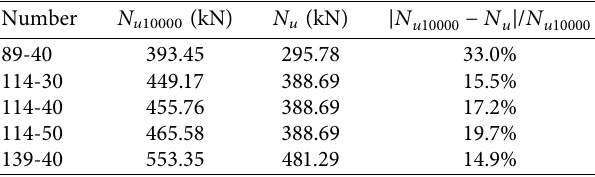
Table 6: Bearing capacity comparison